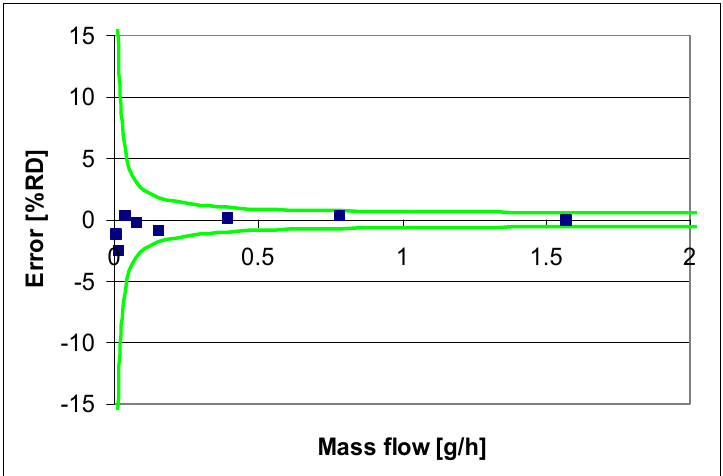
Figure 9. Measured isopropanol (IPA) mass flow vs. Syringe (100 µL Hamilton gastight on Harvard PHD ultra). The envelope represents a zero stability of 2 mg/h and an accuracy of 0.5% reading. The pressure drop across the Coriolis mass flow meter was approximately 2